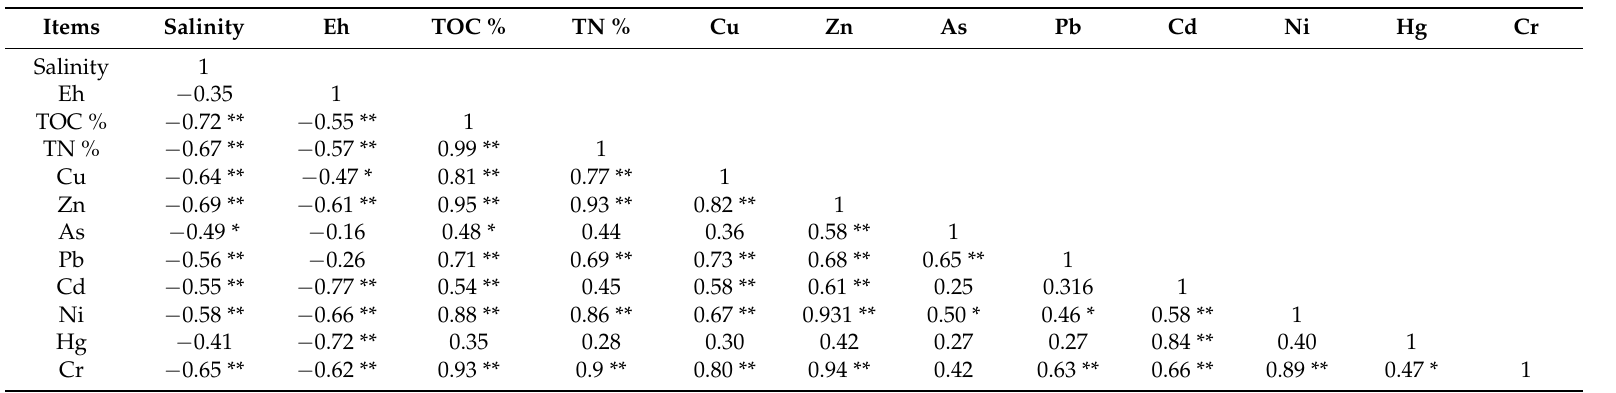
Table 2. Pearson correlation (PC) coefficient matrix of heavy metals, salinity, redo potential (Eh), total nitrogen (TN), and total organic content (TOC) in the surface sediments of Daya